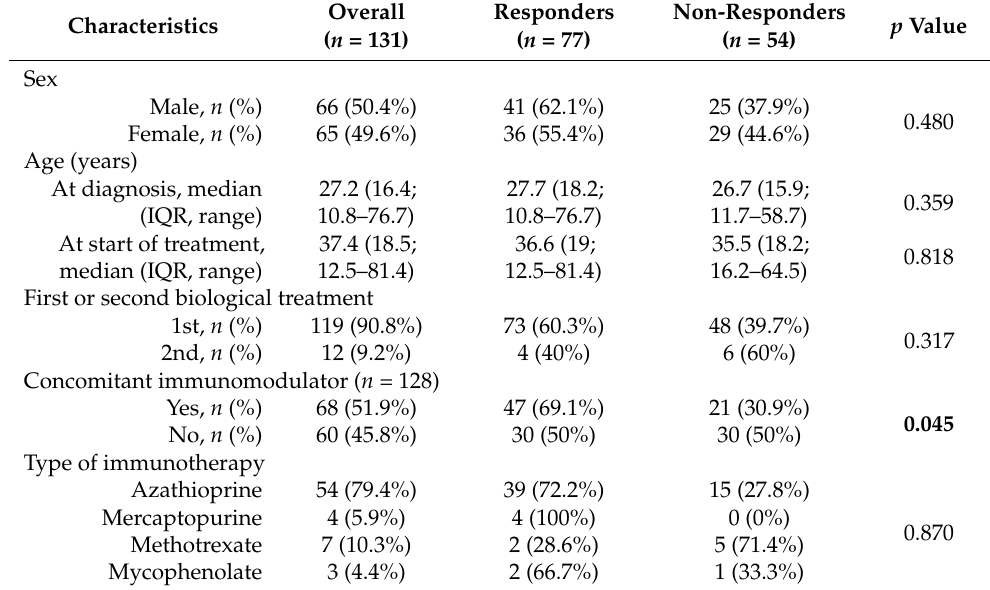
Table 2. Characteristics of adult